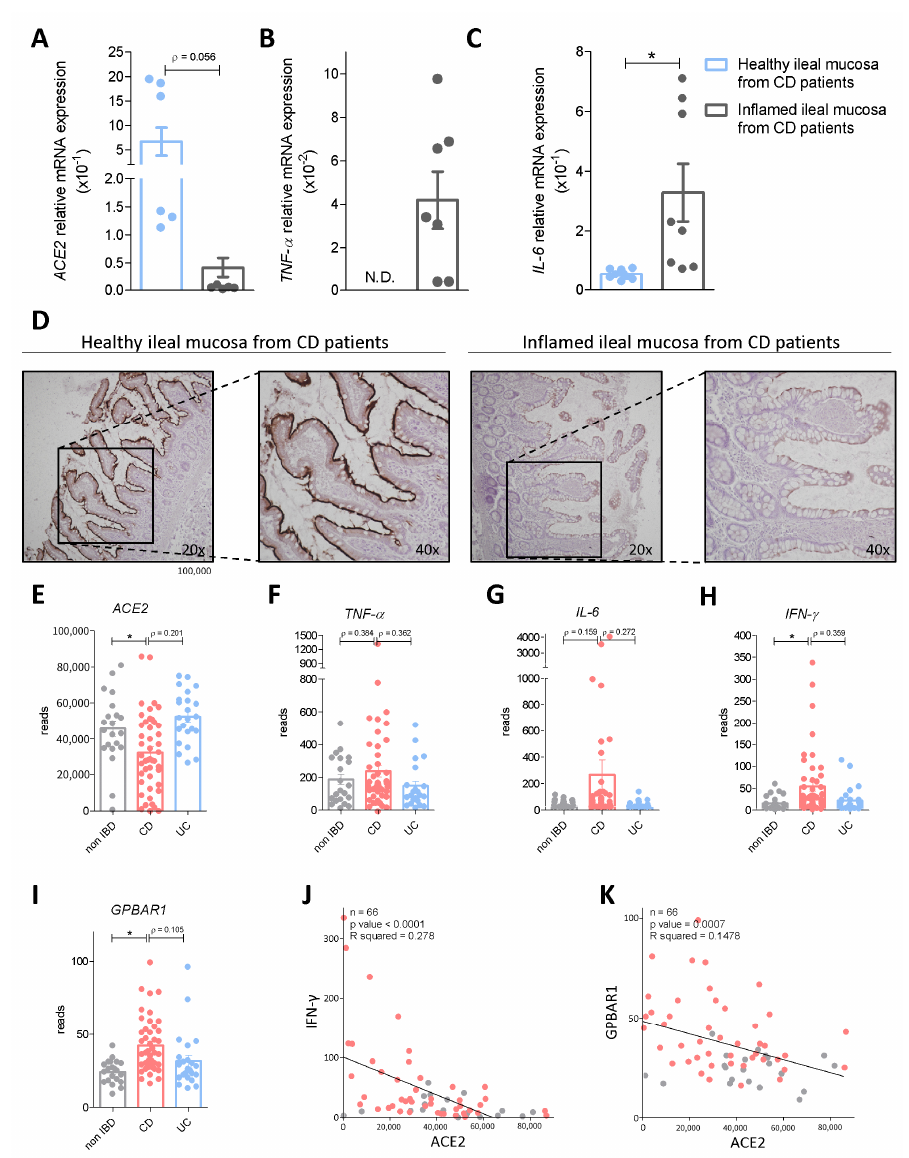
Figure 1. ACE2 mRNA expression varies in healthy or inflamed ileus in an opposite way to that of the colon. The relative mRNA expression of ( A ) ACE2, ( B ) TNF- α and ( C ) IL-6 in colon biopsies from healthy and inflamed ileal mucosa from Crohn’s disease (CD) patients. Data are normalized to GAPDH mRNA. Results are the mean ± SEM of 9 patients per group; * p < 0.05. ( D ) Immuno- histochemistry analysis of ACE2 expression in non-inflamed and inflamed ileum samples obtained from CD patients (Magnification 20× and 40×). ( E–I ) RNA-seq analysis of ileal biopsy samples from HMP2 project CD, UC and non-IBD patients. Each dot represents a patient. Gene profile expression of (D) ACE2, ( E ) TNF- α , ( F ) IL-6, (G) IFN- γ ( H ) and GPBAR1. ( I–K ) Correlation graph between ( I ), INF- γ and ACE2 expression ( J ), and GPBAR1 and ACE2 ( K ). * p < 0.05.